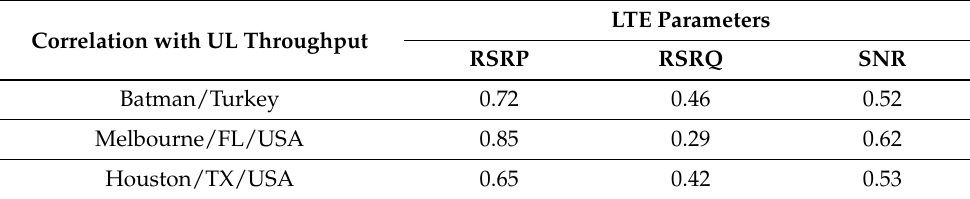
Table 1. Correlation Between UL Throughput and Received Signal Level (RSL).